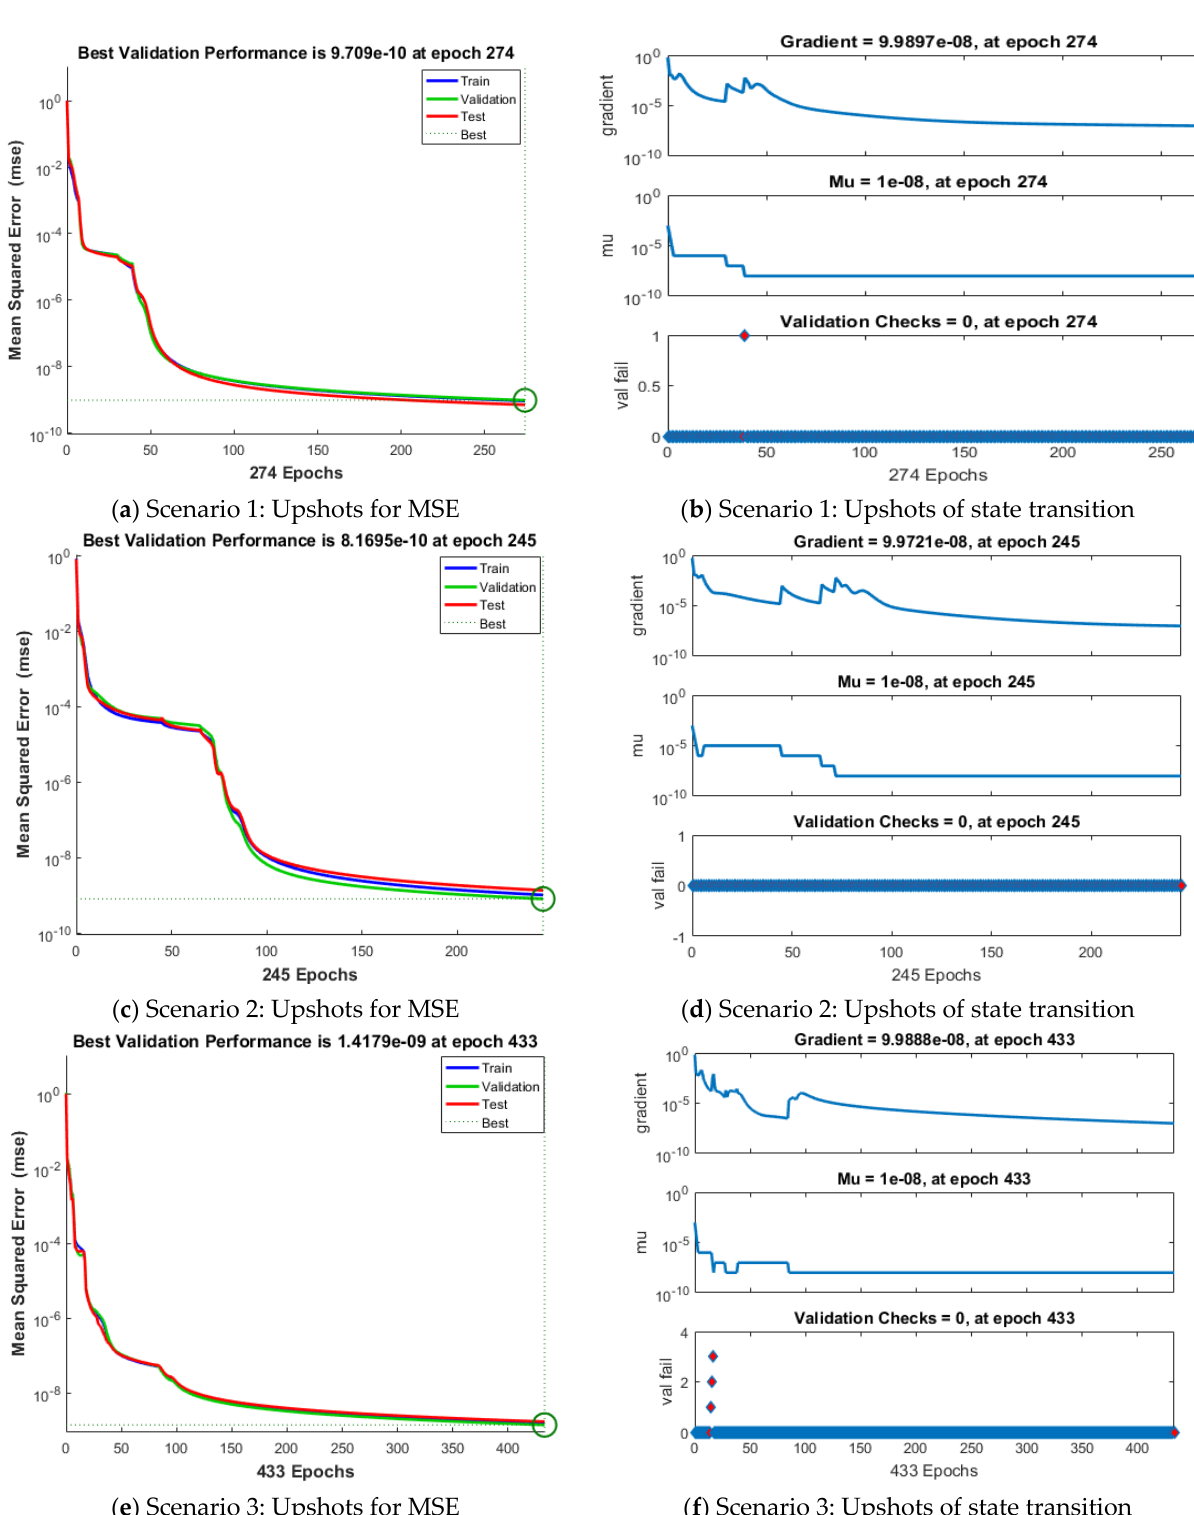
Figure 4. Solution of performance and state transition of proposed TLMB-NN for solving HTM-BFN model with MHD for scenarios 1–3.